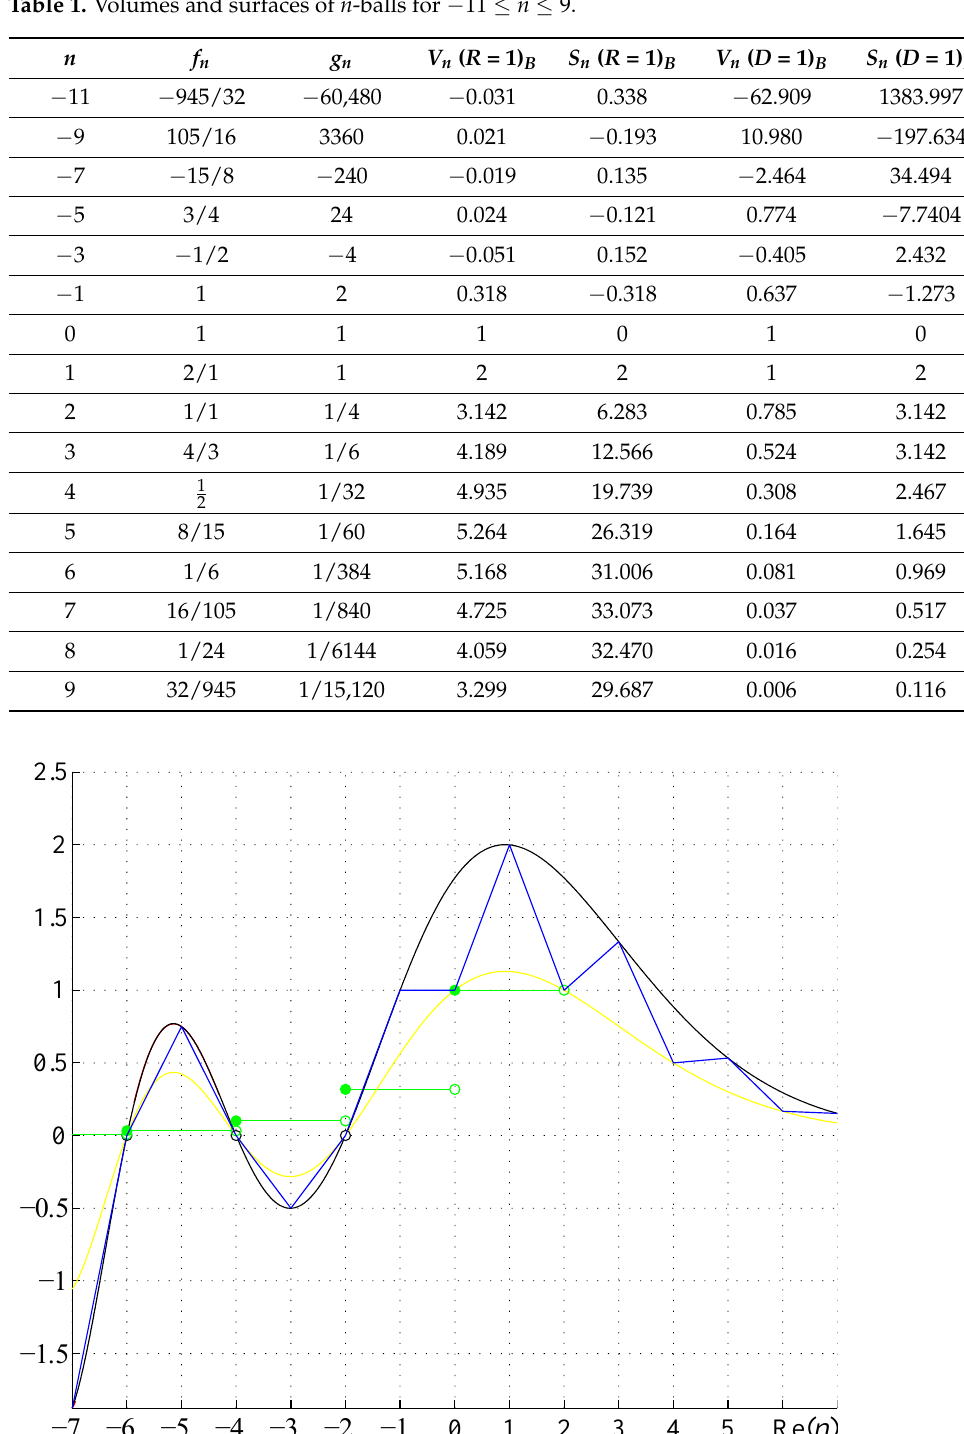
Figure 2. Graphs of volumes ( V ) and surface areas ( S ) of n -balls of unit radius for n = − 25, − 24, … ,15. Table 1. Volumes and surfaces of n -balls for − 11 ≤ n ≤ 9. n